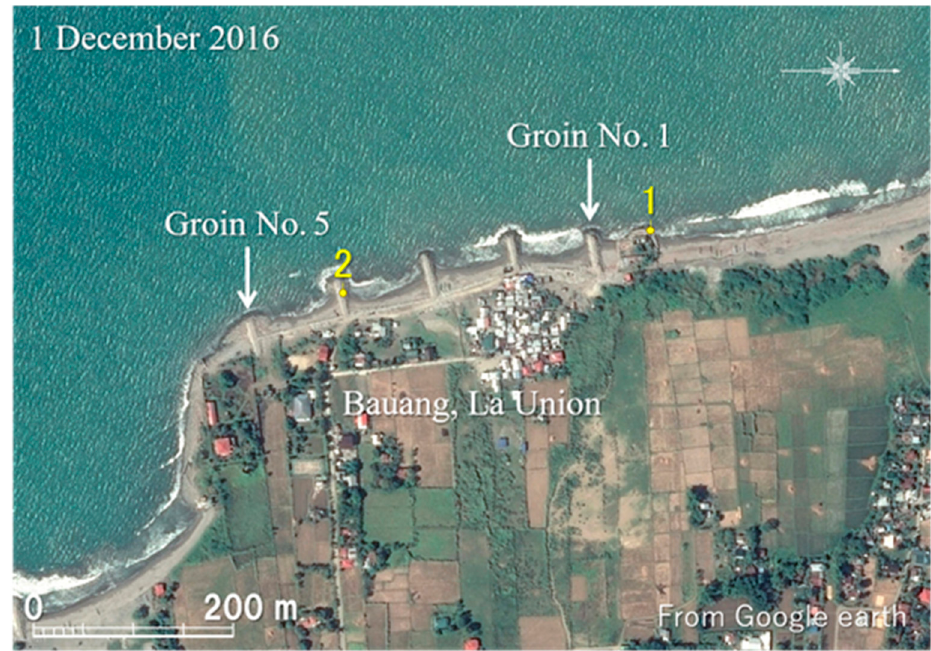
Figure 8. Enlarged satellite image of rectangular area in Figure 7. Sites 1 and 2 are the locations where site photographs were taken in the field observation.